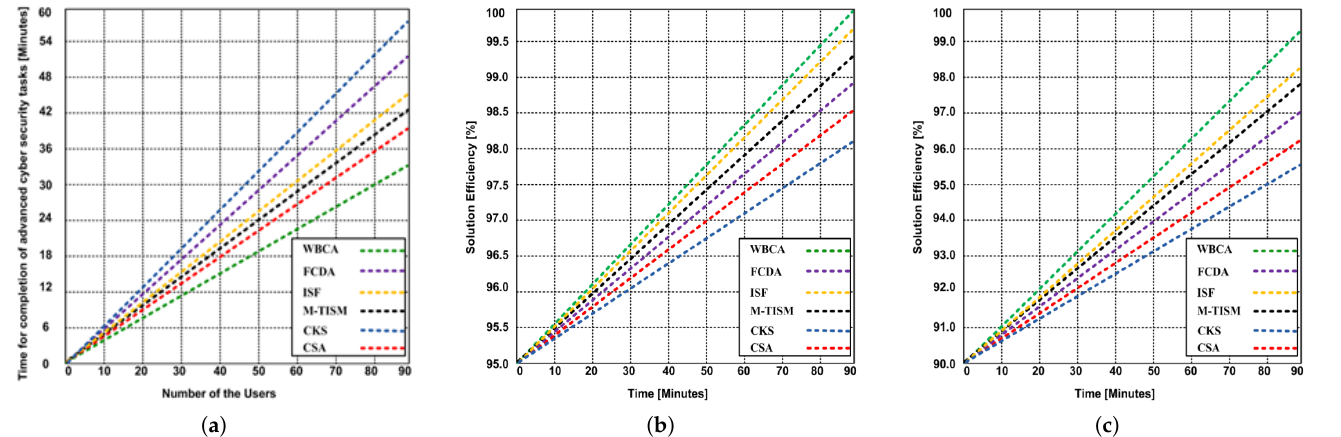
Figure 5. ( a ) The correlation between the number of users and the time consumed when solving advanced cybersecurity tasks with the proposed WBCA and contending programs (M-TISM, ISF, FDCA, CSA, and CKS). ( b ) The solution efficiency of the proposed WBCA and contending programs (M-TISM, ISF, FDCA, CSA, and CKS) using the basic cybersecurity tasks. ( c ) The solution efficiency of the proposed WBCA and contending programs (M-TISM, ISF, FDCA, CSA, and CKS) using the advanced cybersecurity